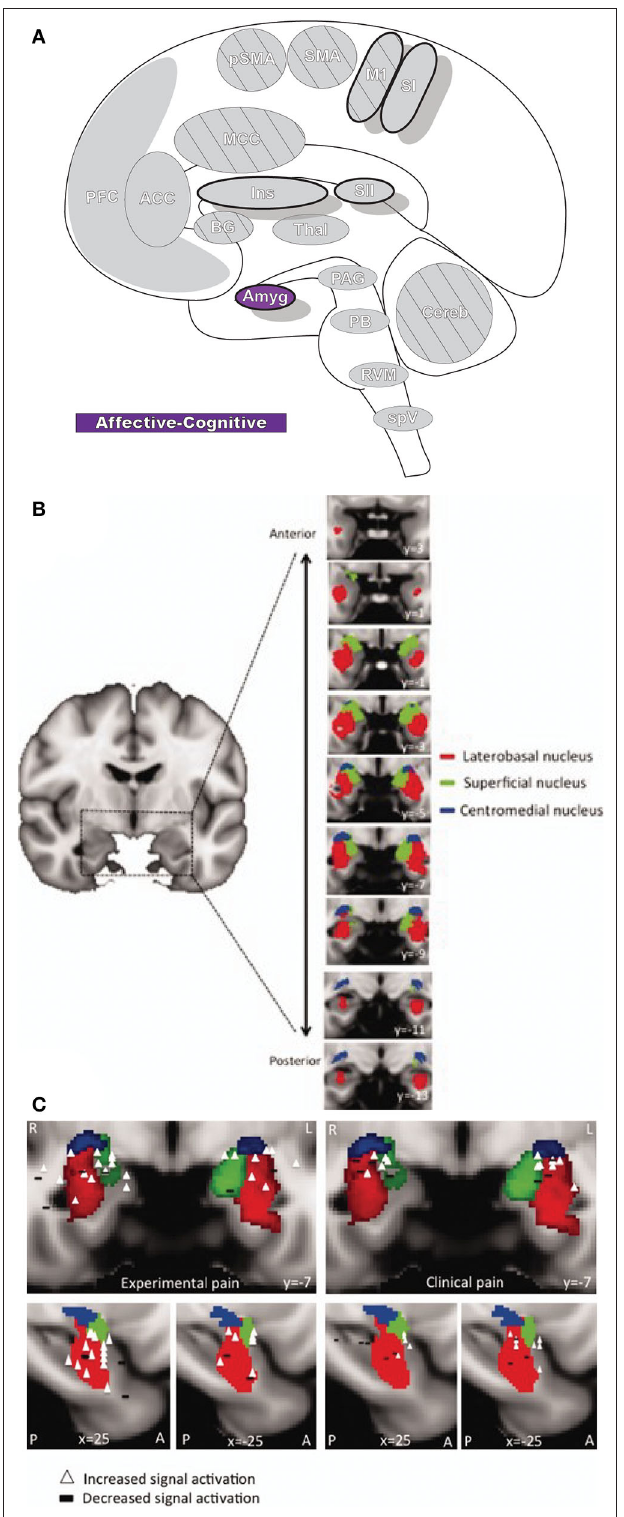
FIGURE 7 | Amygdala. (A) Brain areas active during pain: Amygdala (Amyg) highlighted. (B) MRI imaging of amygdala subunits displayed in a series of